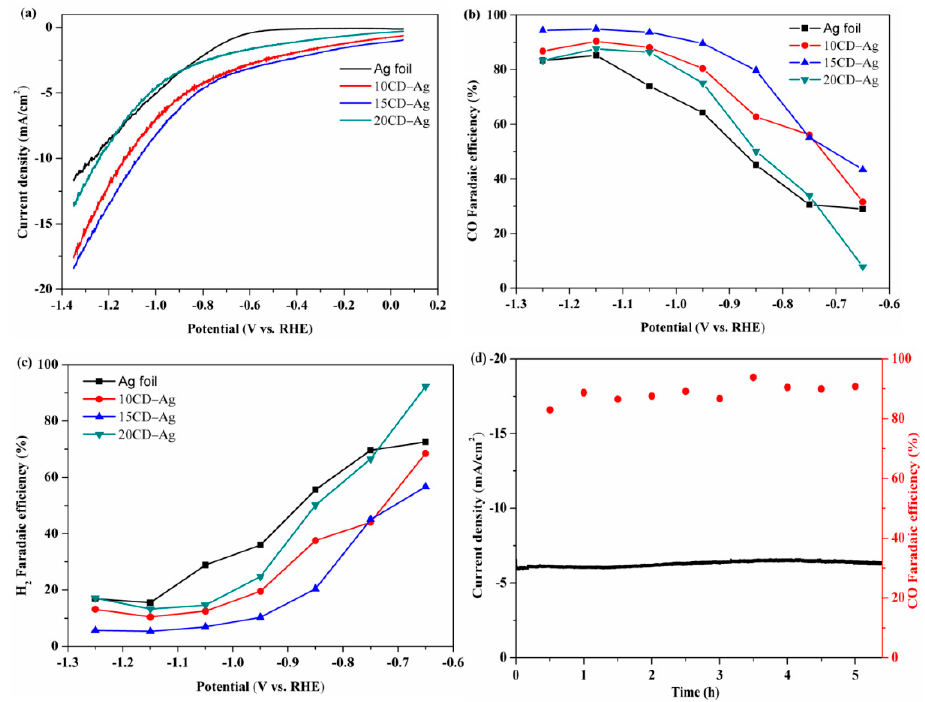
Figure 4. Electrochemical CO 2 RR performance of: ( a ) LSV curves; ( b ) FE of CO; and ( c ) FE of H 2 over different electrodes at various applied potentials and ( d ) Current density and FE of CO vs. reaction time over 15 CD − Ag electrode during 5 h of long − time operation at − 0.95 V vs. RHE.